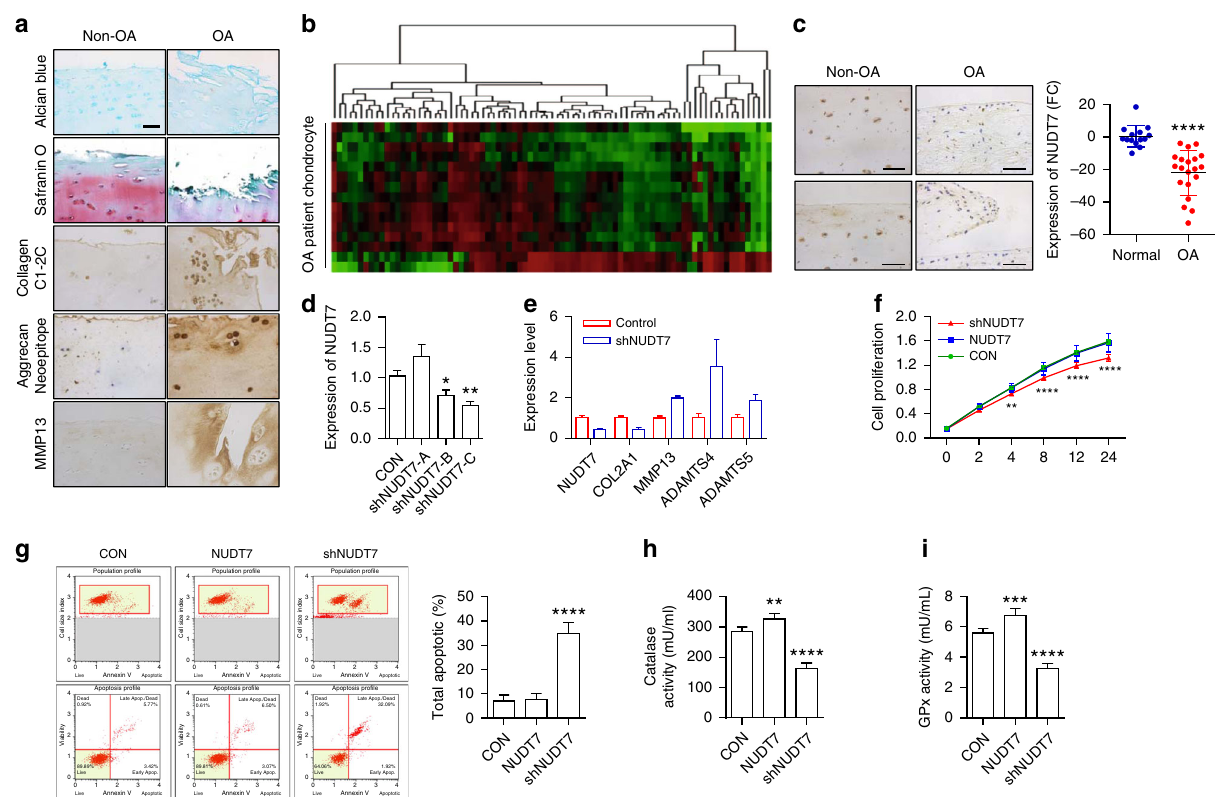
Fig. 1 NUDT7 , a peroxisomal gene, is suppressed during osteoarthritis (OA) pathogenesis. a Staining with Alcian blue or safranin O and immunohistochemistry of Collagen C1-2C, Aggrecan Neoepitope, and matrix metalloproteinase (MMP)-13 using non-OA and OA cartilage from human patients with OA pathogenesis ( n = 5 per group). Scale bar, 50 μ m. b Transcription levels of 94 peroxisome-related genes in human OA chondrocytes ( n = 15 per group) compared with those in normal chondrocytes ( n = 8 per group). c Immunostaining of NUDT7, and the mRNA level of NUDT7 in human OA chondrocytes ( n = 20 per group) compared with that in normal chondrocytes ( n = 13 per group). Scale bar, 50 μ m. d Transcription level of NUDT7 in normal chondrocytes infected with lentivirus containing each NUDT7 short hairpin RNA (shRNA). e Transcription level of matrix-degrading enzymes in normal chondrocytes infected with lentivirus containing an NUDT7 shRNA ( shNUDT7 ) ( n = 3). f , g Analysis of cell proliferation ( n = 4 per group) and apoptotic cell death ( n = 6 per group) in normal chondrocytes infected with lentivirus containing NUDT7 or NUDT7 shRNA. h , i Activities of catalase and glutathione peroxidase (GPx) in normal chondrocytes infected with lentivirus containing NUDT7 or NUDT7 shRNA ( n = 6 per group). Values are means + s.d. An unpaired Student ’ s t test was used for statistical analysis. * P < 0.05, ** P < 0.01, *** P < 0.001, **** P <